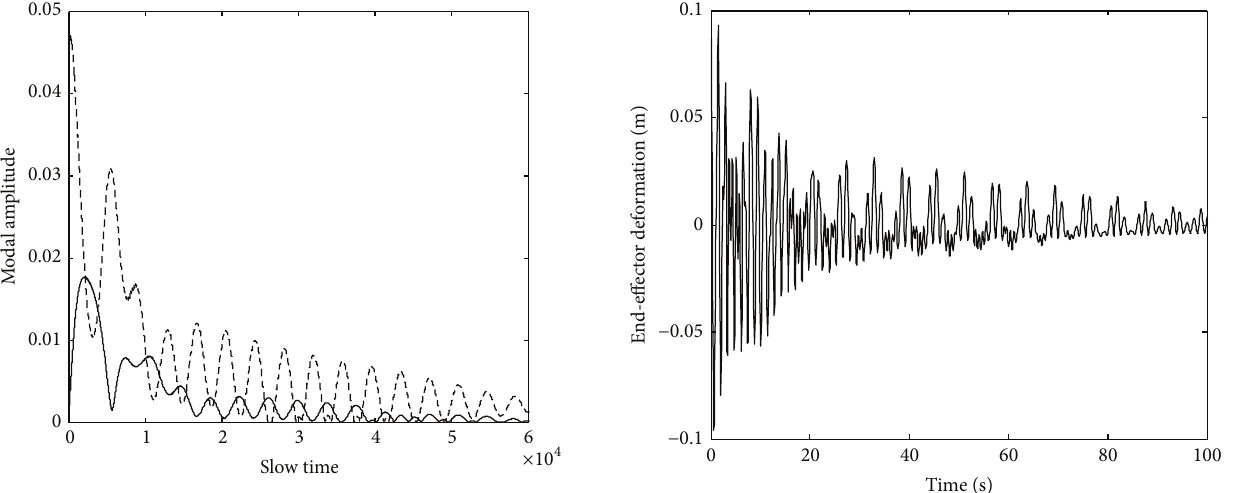
Figure 12: Response of the controlled arm ( 𝛿(𝑙, 0 ) = 0 . 1 m).